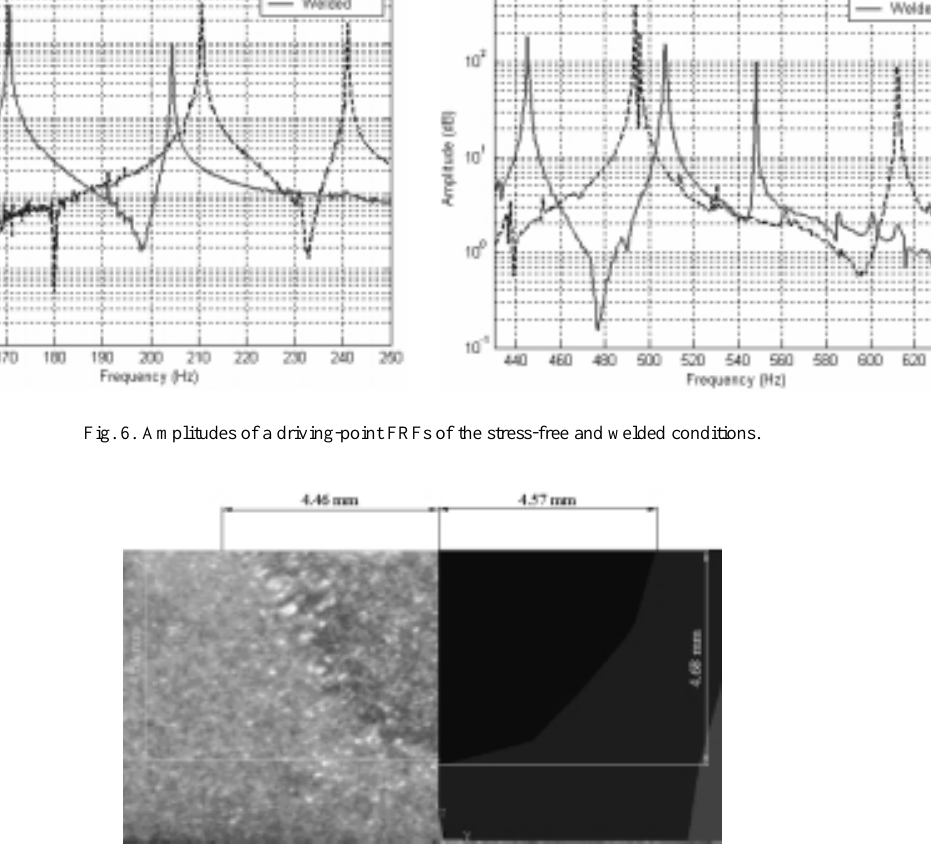
Fig. 7. Comparison of numerical and experimental fusion zones at cross-section x = 170